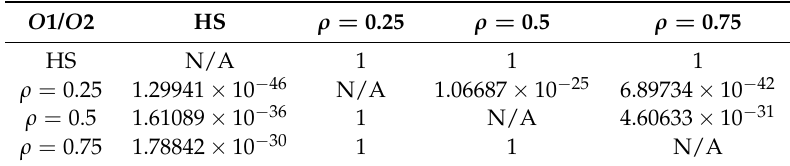
Table 5. Wilcoxon Signed-Rank Test results for the value of the objective